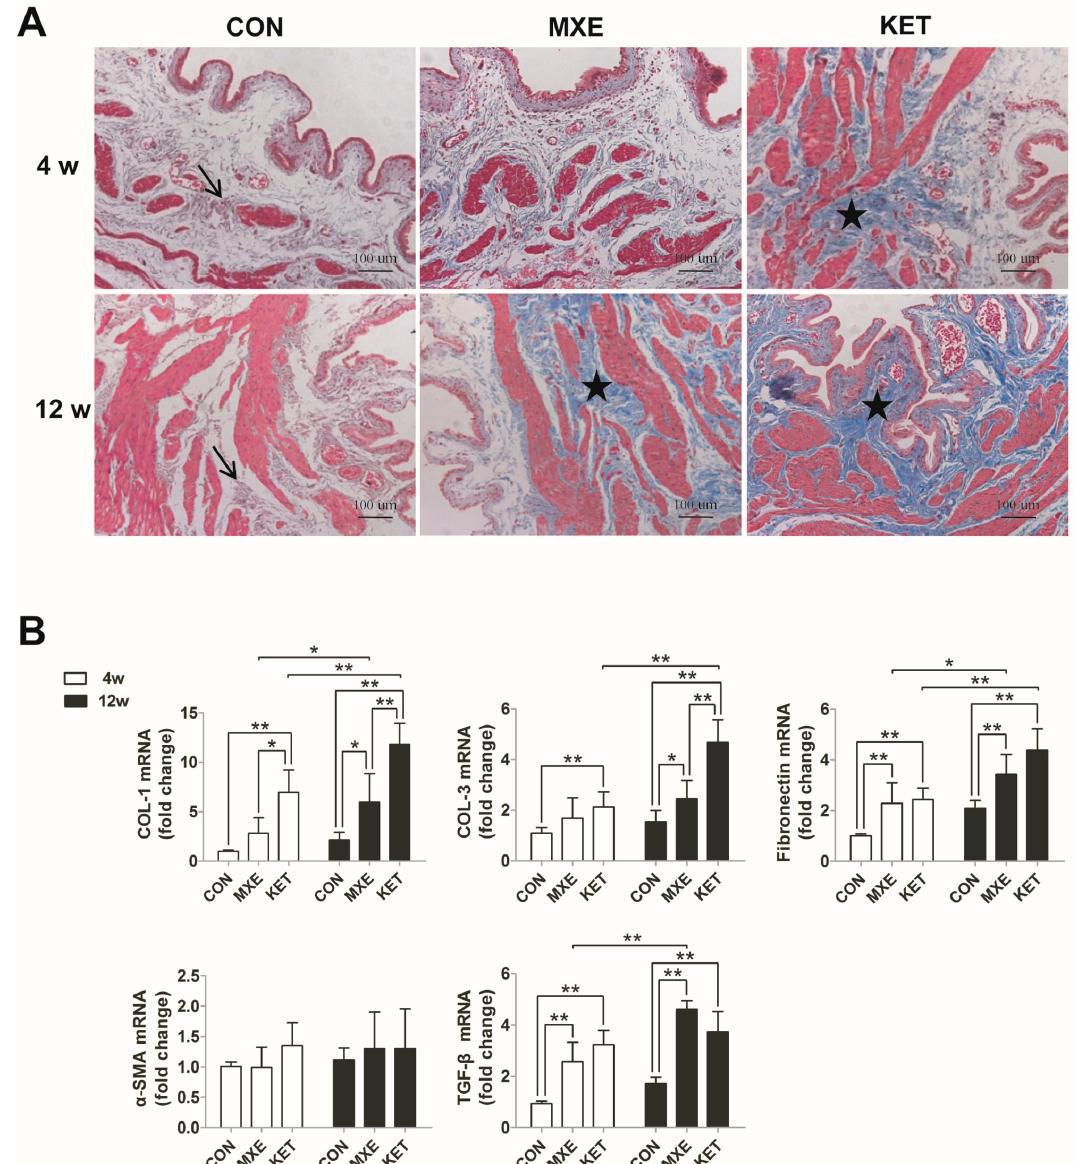
Figure 7. MXE and KET administration induced matrix deposition and interstitial fibrosis in rats after four and 12 weeks. ( A ) Representative graphs of Masson trichrome staining results in the different groups ( n = 6 in each group). (magnification: × 100; scale bar: 100 µ m). In the age-matched control group, only a few discrete light blue stained collagen deposits (arrows) were observed among the muscle bundles. Treatment with ketamine for four weeks or methoxetamine for 12 weeks caused significant increases in dense connective tissue and collagen deposits between the muscle bundles (asterisks); primarily in the submucosal and muscular layers. Bladder tissues from the 16-week KET group were characterized by the disappearance of lamina propria and submucosa, rather than by diffuse interstitial fibrosis; ( B ) expression levels of genes for collagen I (COL I), collagen III (COL III), fibronectin, α -SMA, and TGF- β . Data are expressed in mean ± SD, as the fold-change vs. the mean value in the control group at four weeks. Two-way ANOVA were used for analysis. * p < 0.05, ** p < 0.01.